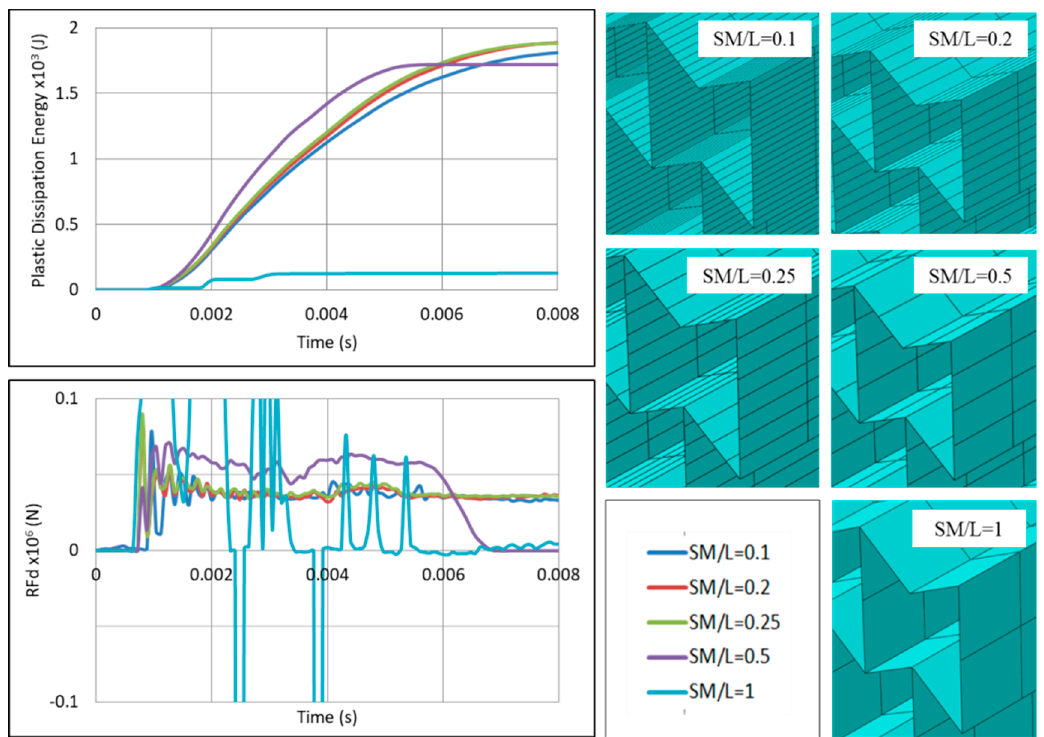
Figure 3. Mesh sensitivity study. Finding the most accurate-less expensive auxetic core model (different SM/L ratios), based on comparing plastic dissipation energy (PDE) and reaction force (RFd), for an auxetic core of L = 10 mm, t = 1 mm, S4R elements, AL3 aluminium, pulse load of 0.5 × 10 6 N in 0.002 s.